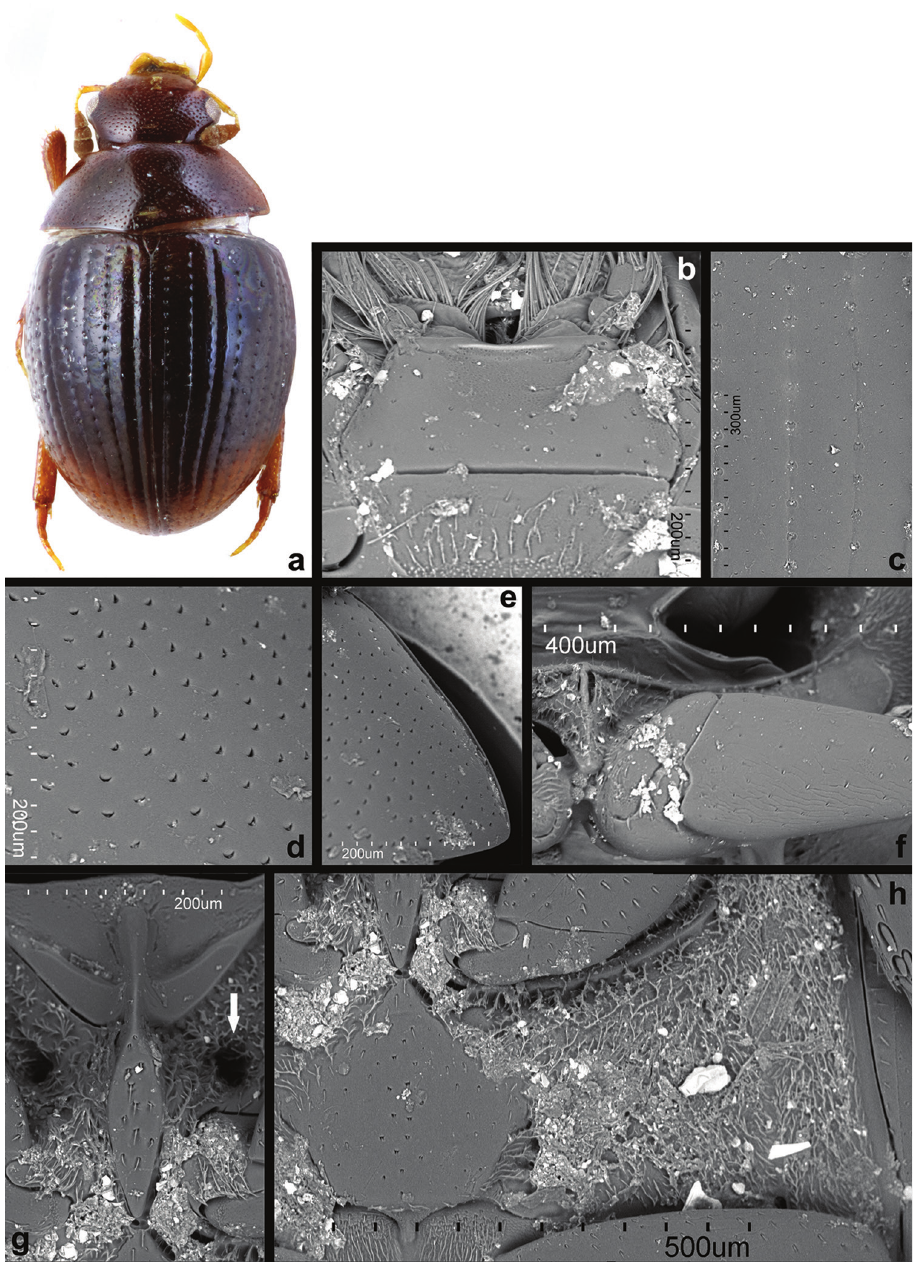
Figure 9. Cercyon ( Acycreon ) apiciflavus Hebauer a dorsal habitus b labium c detail of elytral surface d detail of head surface e detail of pronotal surface and lateral margin f prosternum g mesoventral plate (arrow pointing to the setose pore) h